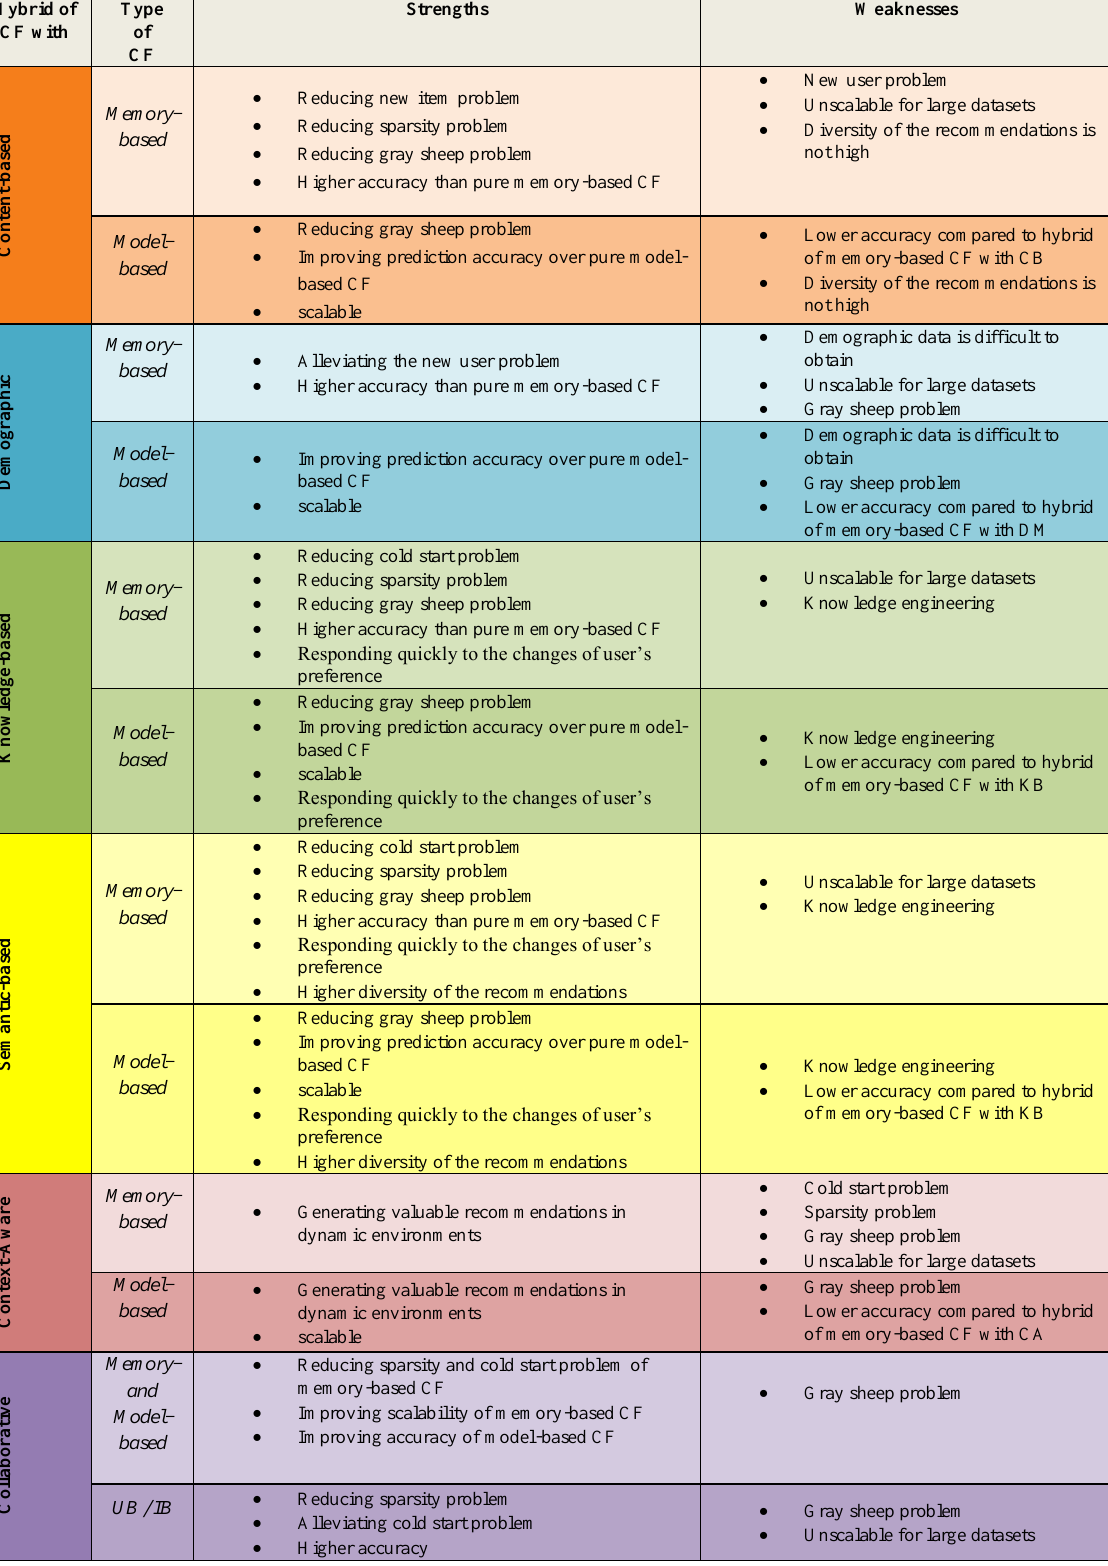
Table 2. Comparison of the different hybrid CF